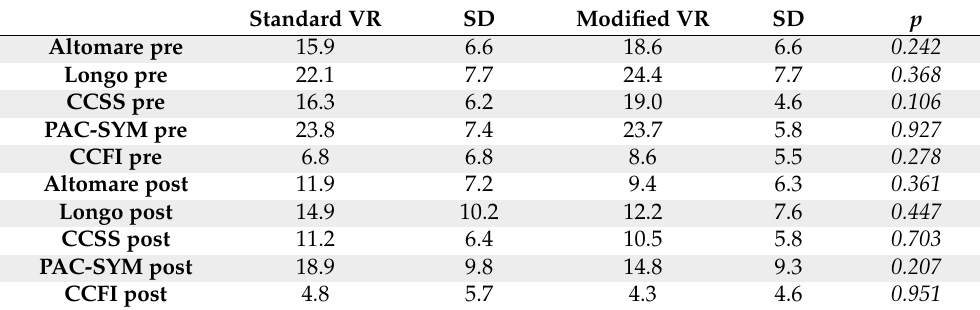
Table 3. Comparison between pre- and postoperative values of clinical scores in patients with only external rectal prolapse who underwent standard vs. modified ventral rectopexy (Mann–Whitney U